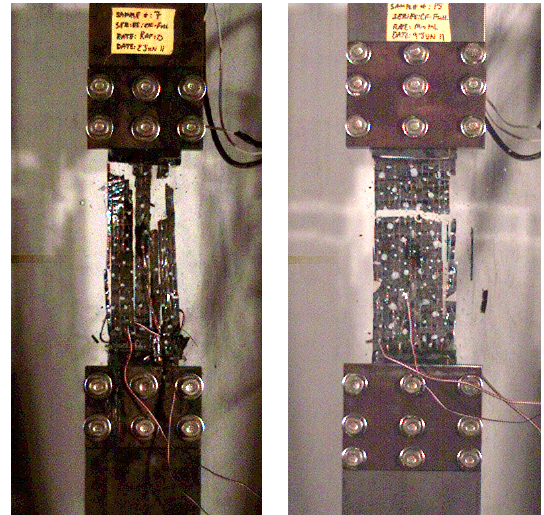
Figure 12. High speed failure stills of Coupon #5 ( left ) and Coupon #13 ( right